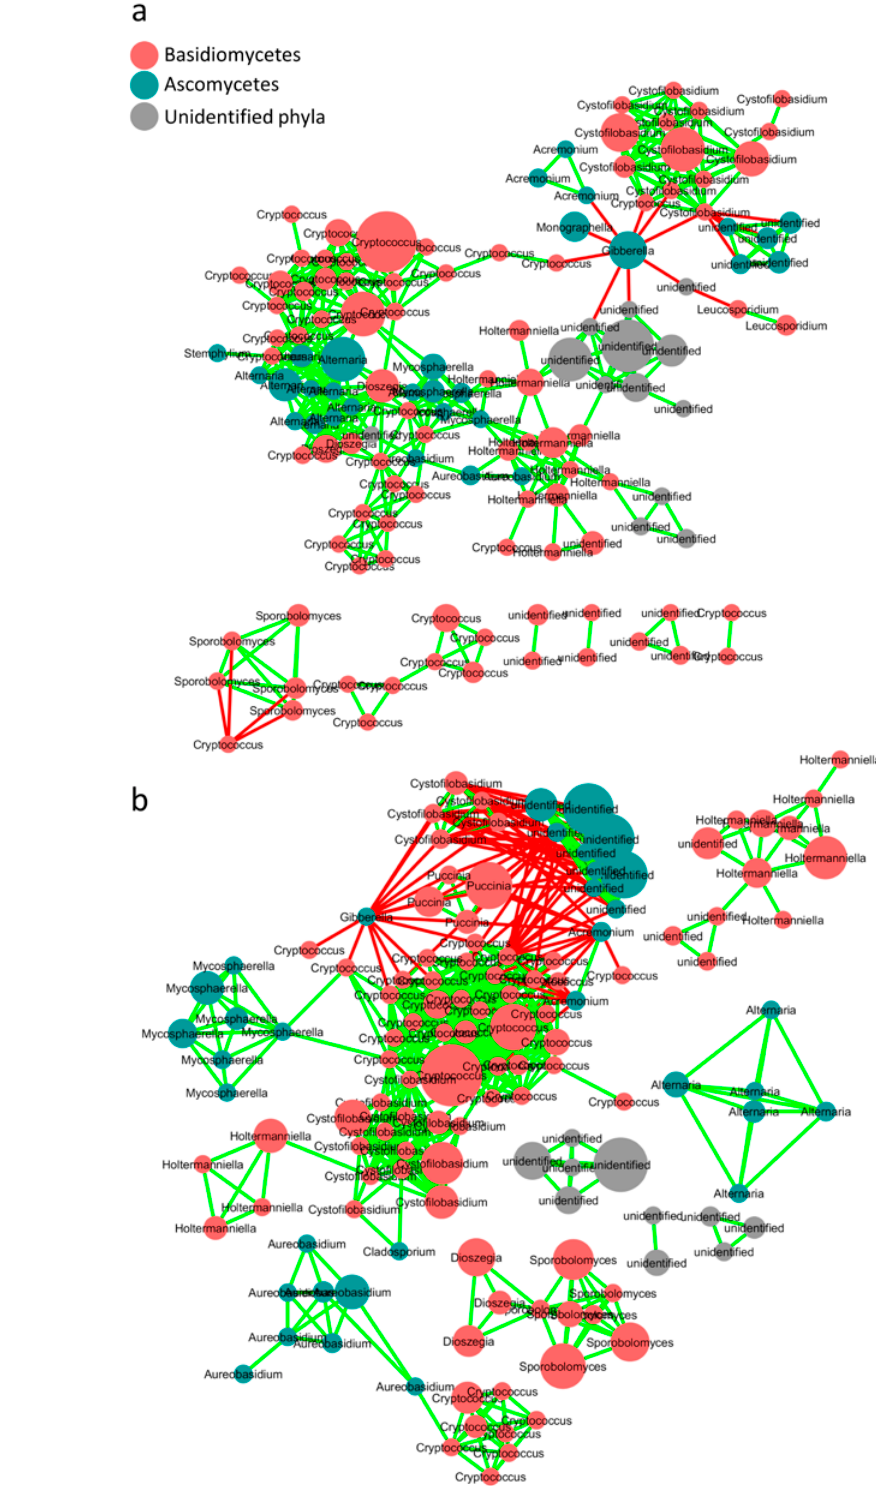
Figure 7. Microbial association network showing the interactions (co-occurrence and mutual exclusion) represented by green links for wheat variety Perciasacchi (a) and red links for Tumminia (b) The size of the nodes indicates OTU abundance. Node colours differentiate fungal phyla. Interactions were calculated by CoNet and visualised in Cytoscape